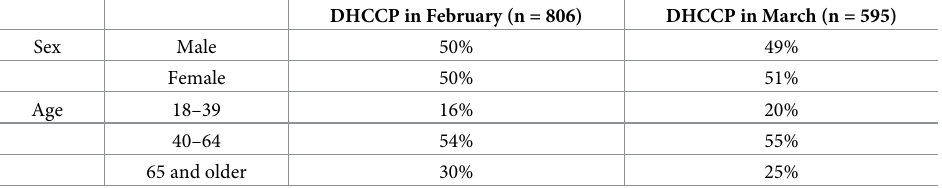
Table 1. Composition of the respondents of the Dutch Health Care Consumer Panel in February and March.